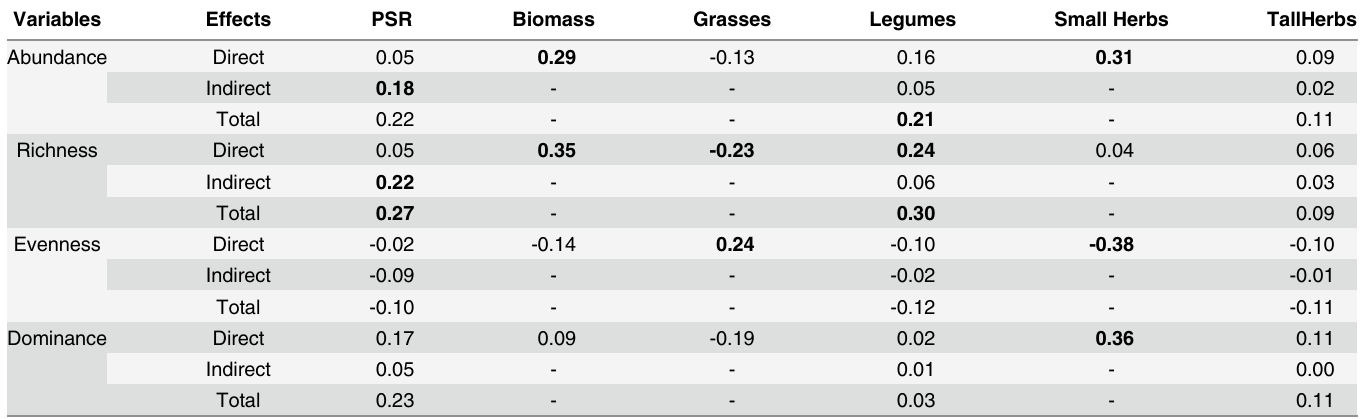
Table 2. Standardized SEM coefficients for carnivore diversity indices. Direct, indirect and total effects of plant species richness (PSR) on carnivore abundance, species richness, shannon evenness and dominance. Indirect effects are computed as the product of the PSR effect on plant biomass and the plant biomass effect on the diversity indices. Total effects are the sum of direct and indirect effects. Reported are also the effects of the four plant functional groups (Grasses, Legumes, Small Herbs and Tall Herbs). Coefficients in bold indicate a p-value < 0.05.